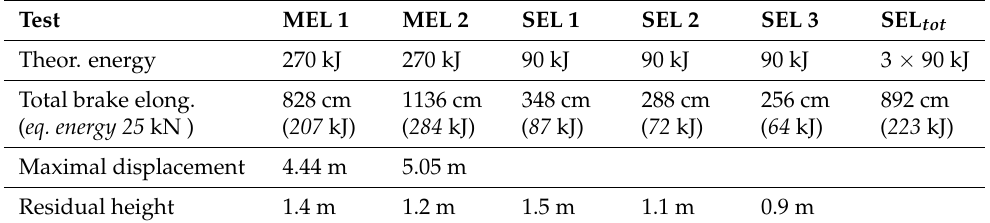
Table 1. Characteristics recorded for each of the two MEL and three SEL impacts—first